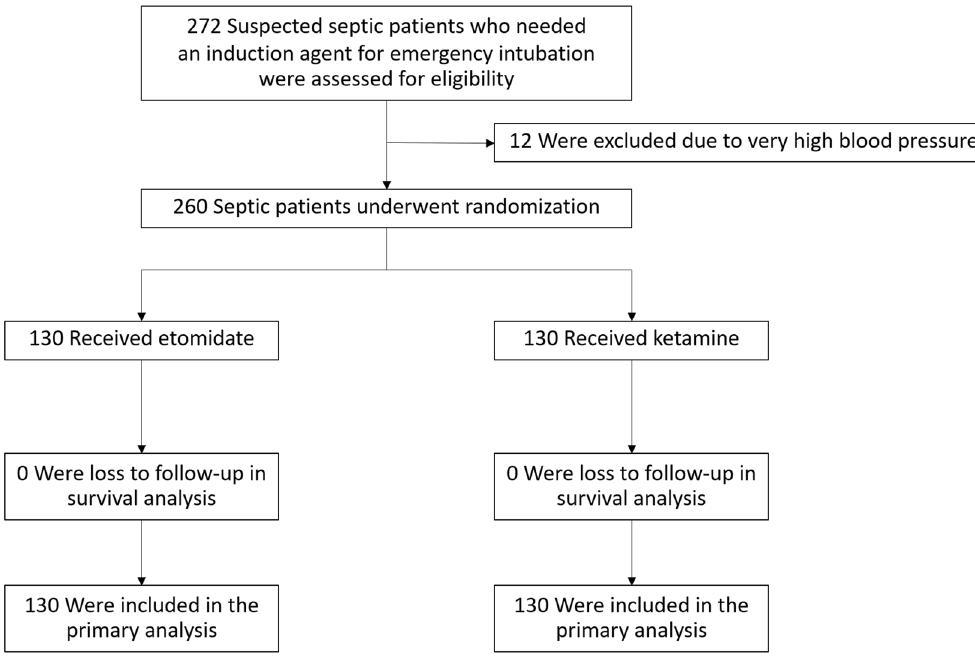
Figure 1. Flow diagram of the study patients